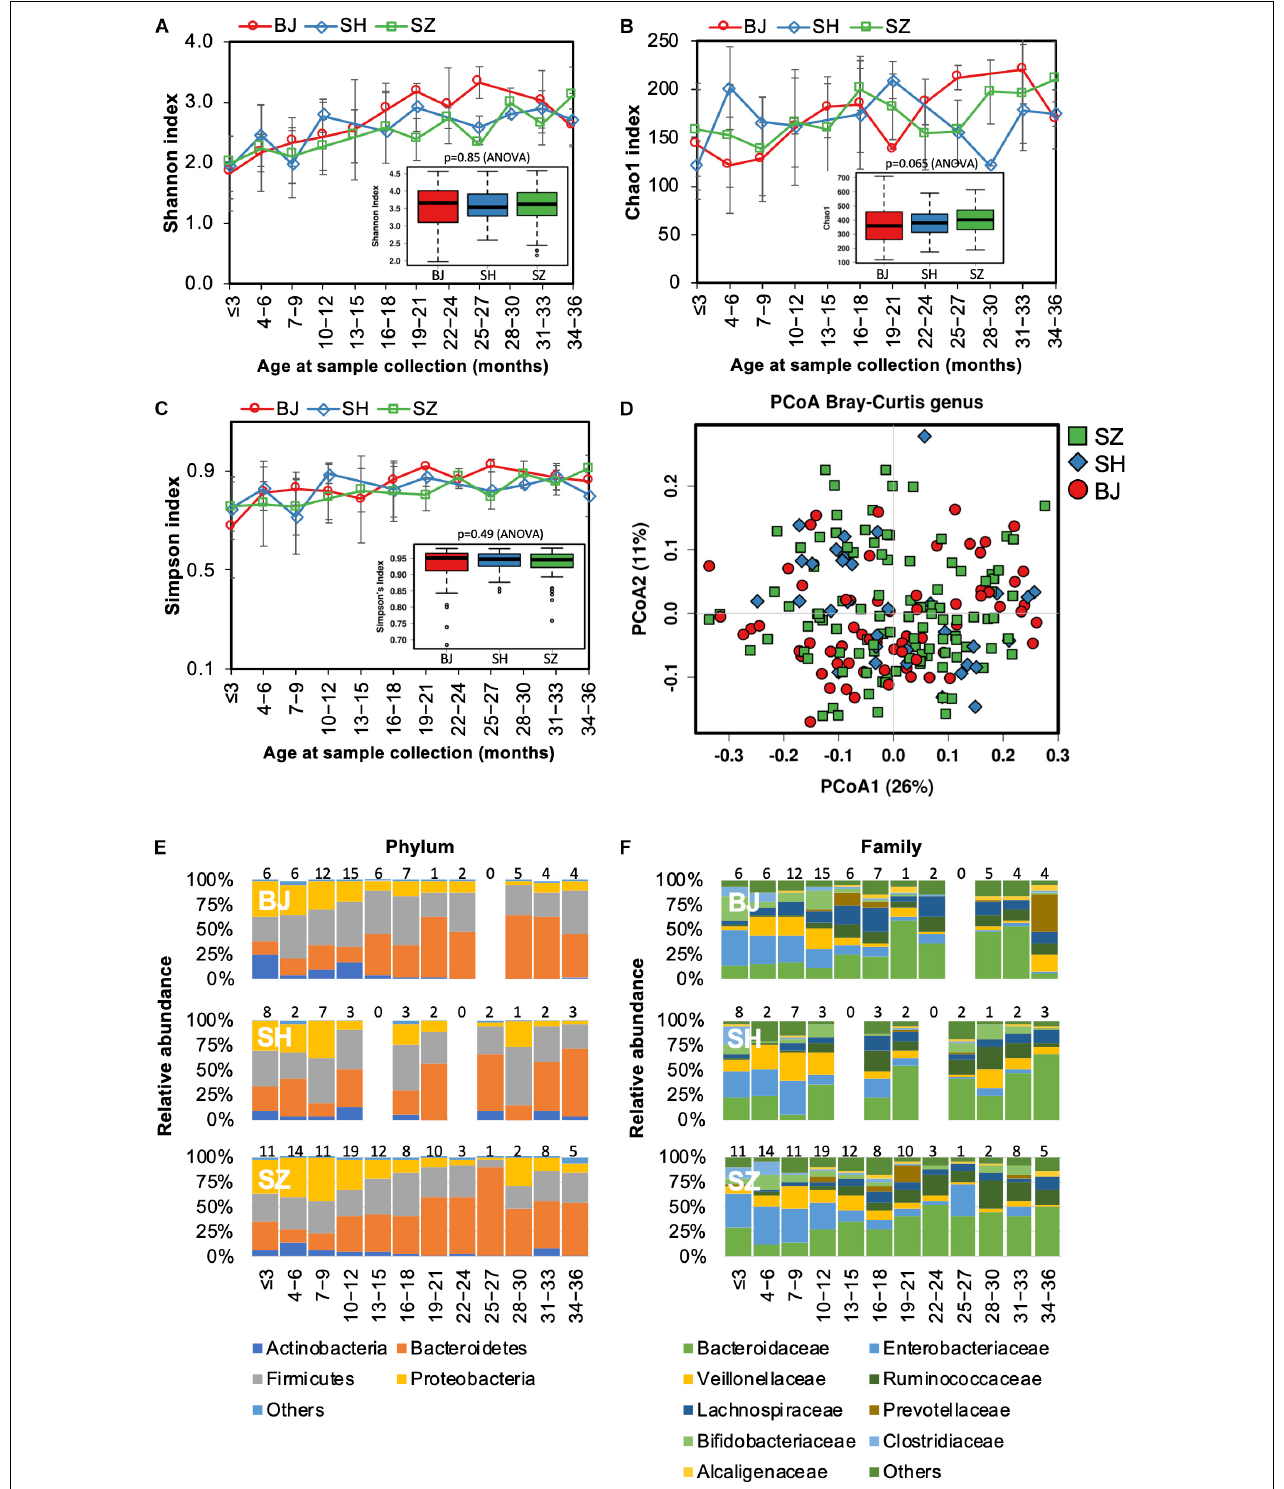
FIGURE 6 | Fecal microbiota diversity and composition for 729 children according to geographical location. Alpha diversity, which was calculated with (A) Shannon index, (B) Chao1, and (C) Simpson’s index, showed no significant difference among the children from three first-tier cities of China. (D) PCoA showed no clear separation among samples of different geographical locations. Gut bacterial microbiota composition at the (E) phylum and (F) family levels. Number of children per age group is provided above bars.